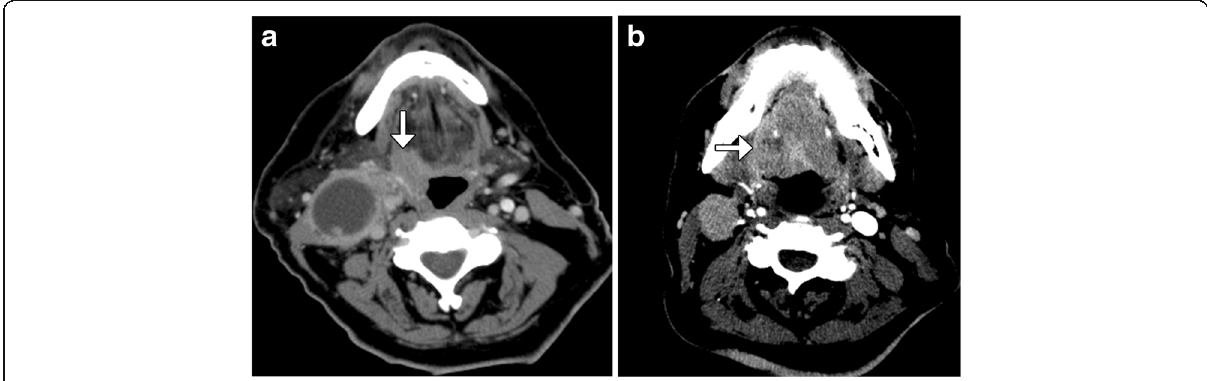
Fig. 1 HPV-positive versus HPV-negative oropharyngeal squamous cell carcinoma. Axial CT image ( a ) shows a well-defined right oropharyngeal mass (arrow) and large cystic right cervical lymphadenopathy in a patient with HPV-positive squamous cell carcinoma. Axial CT image ( b ) shows an infiltrative right oropharyngeal mass (arrow) and solid right cervical lymphadenopathy in a patient with HPV-negative squamous cell carcinoma